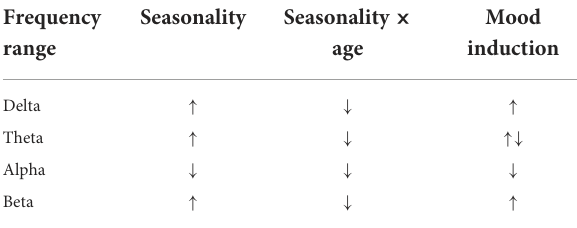
TABLE 4 Summary of the main findings of the study.